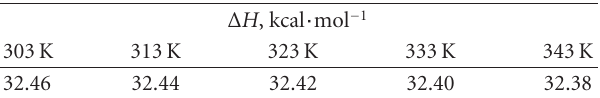
Table 7: The enthalpy of adsorption ( Δ H ) for mild steel in 1.0M HCl in the presence of 2 × 10 − 5 M 3-benzoylmethyl ben- zimidazolium hexafluoroantimonate (BMBI) inhibitor at various temperatures (303K–343 K).